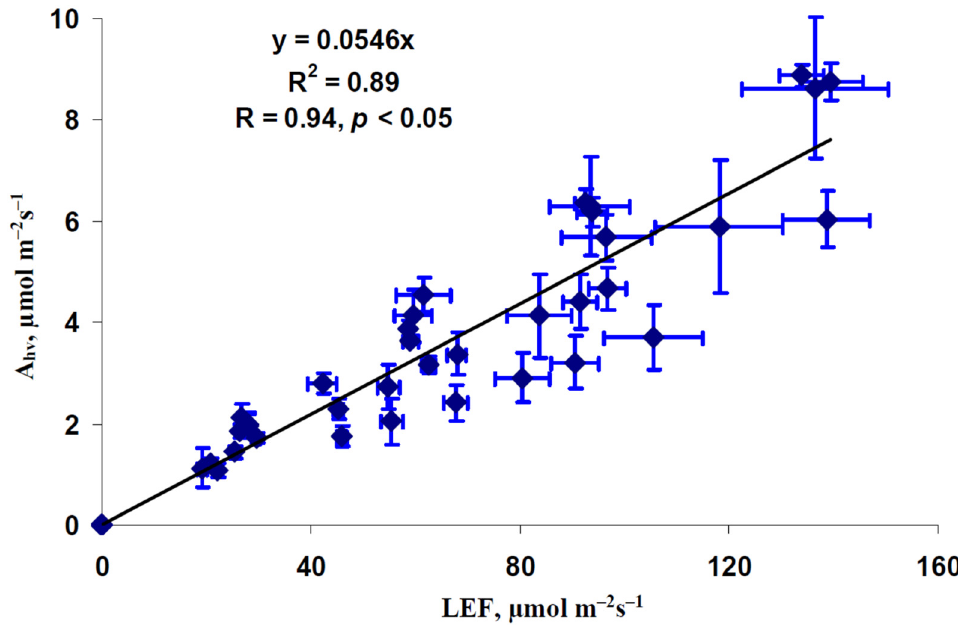
Figure 3. Scatter plot of the photosynthetic CO 2 assimilation rate (A hv ) and linear electron flow (LEF) in lettuce plants ( n = 45). All average values of A hv and LEF from Figure 2 were used. R 2 and R are the determination and correlation coefficients.